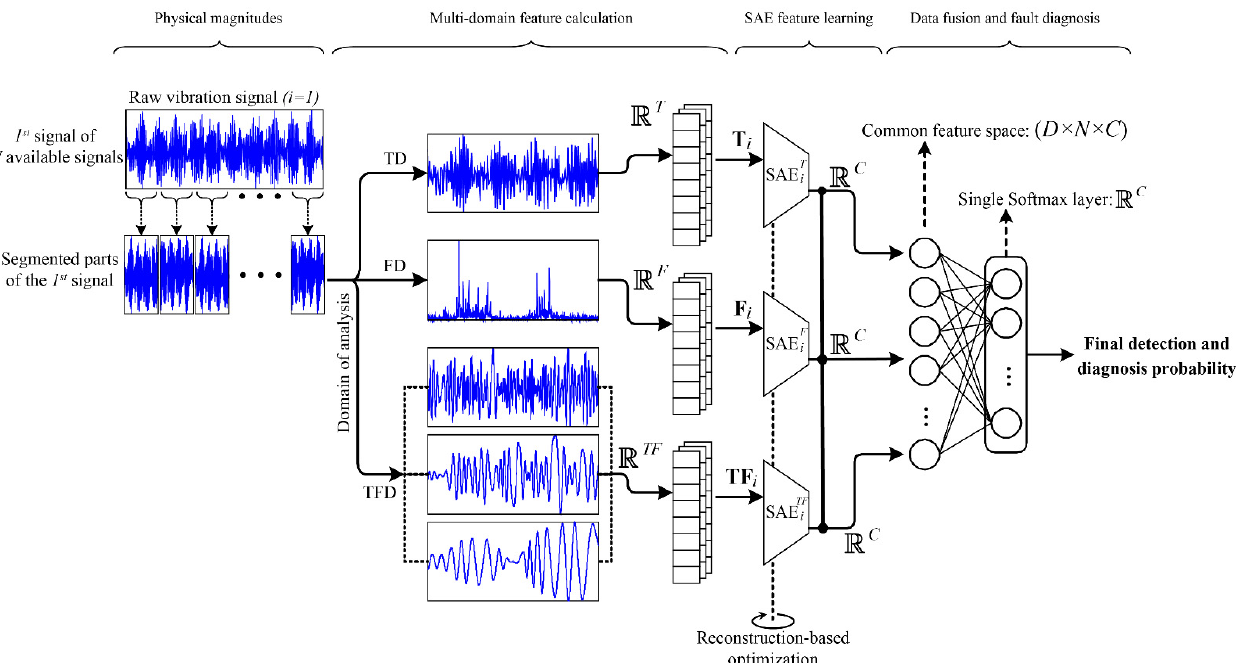
Figure 3. Flow chart of the proposed data-driven diagnosis methodology based on deep feature learning for fault diagnosis applied to the diagnosis and identification of bearing faults for different bearing technologies, such as metallic, hybrid and ceramic bearings, in electromechanical systems.